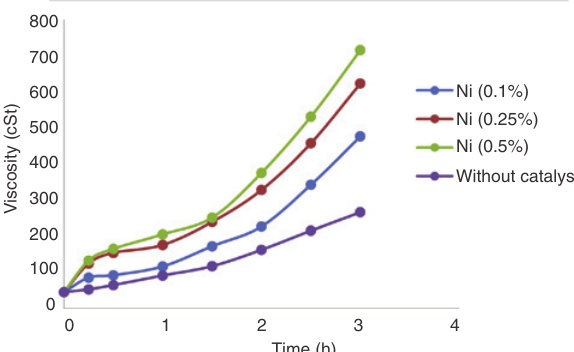
Figure 7: Soybean oil polymerization by Ni complex catalyst at 300 ° C.